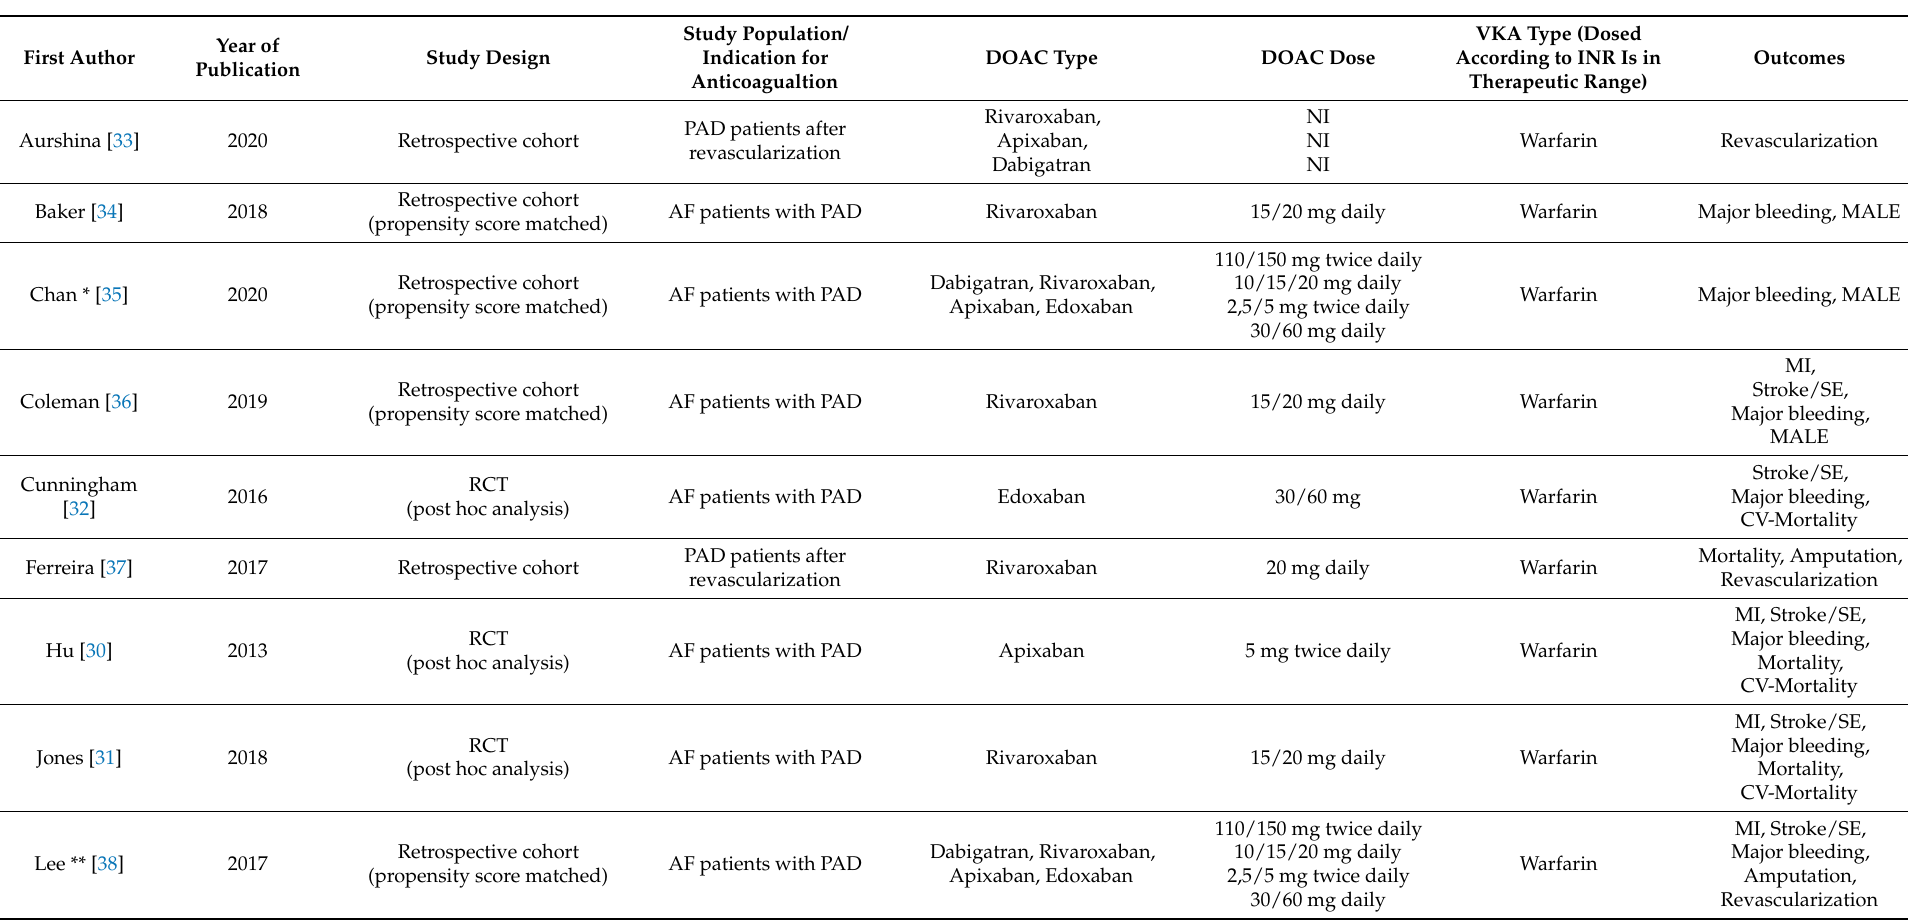
Table 1. Characteristics of the included studies: CV—cardiovascular, DOAC—direct-acting oral anticoagulant, INR—international normalized ratio, MALE—major adverse limb event, MI—myocardial infarction, NI—no information, NVAF—non-valvular atrial fibrillation, PAD—peripheral artery disease, RCT—randomized controlled trial, SE—systemic embolism, VKA—vitamin-K antagonist; * In this study, there were 66%, 89%, 68%, and 95% patients taking low-dose apixaban (2.5